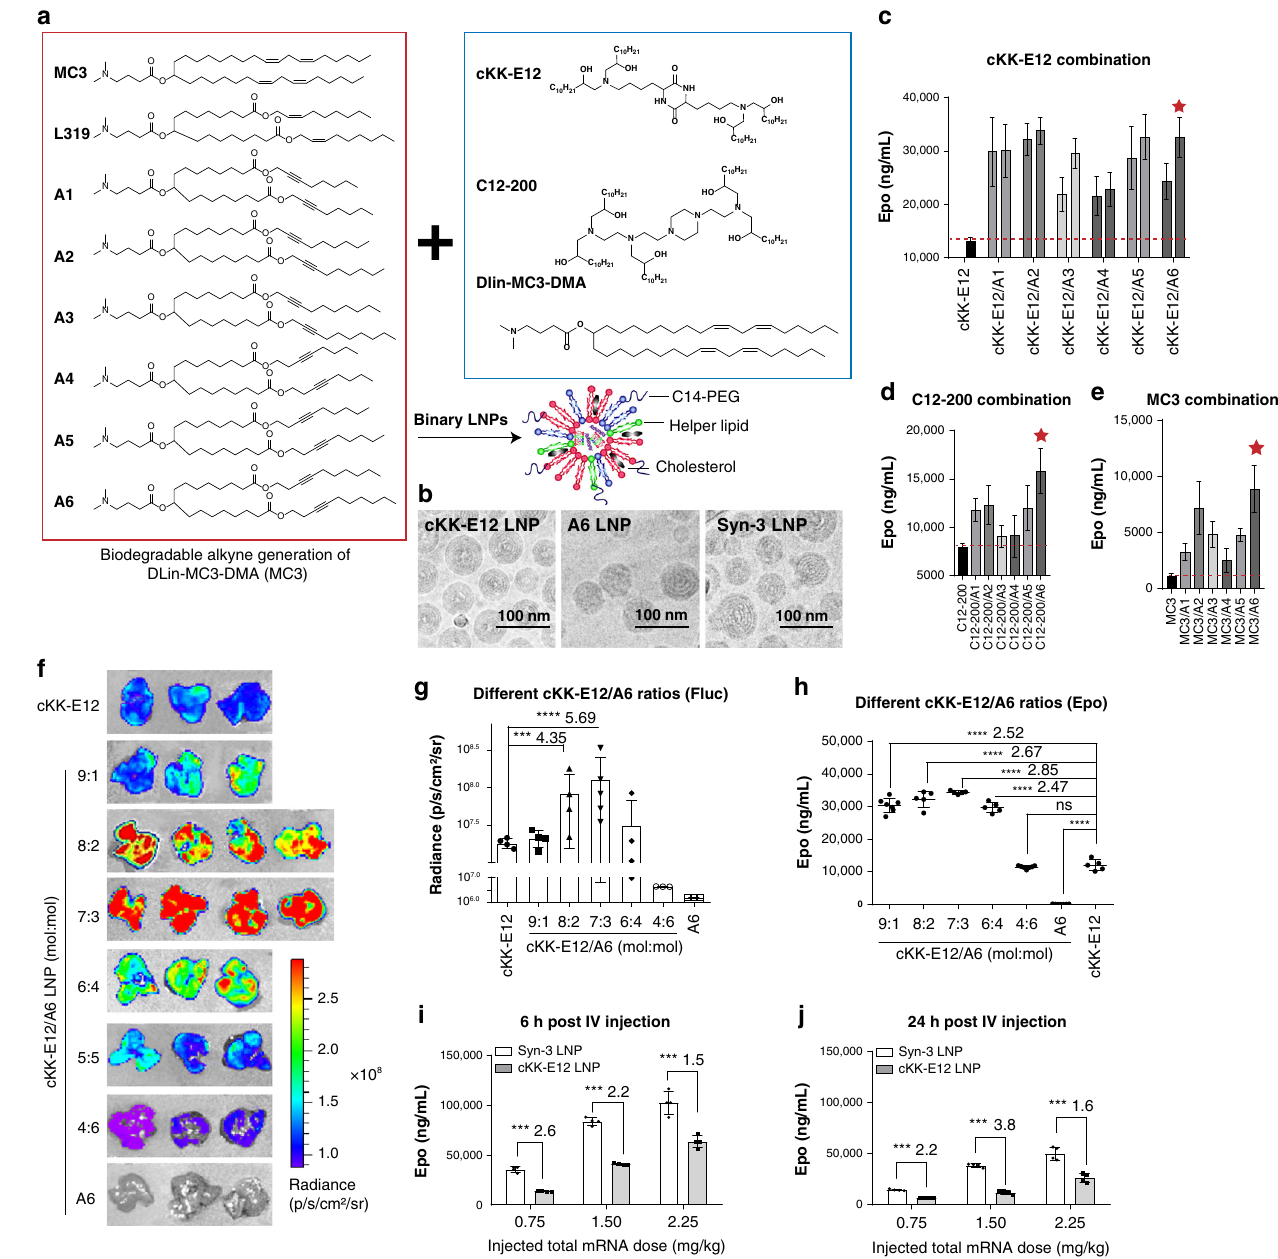
Fig. 1 LNPs containing multiple ionizable lipids demonstrate synergistic mRNA expression in vivo. a Design of biodegradable alkyne lipids and layout of the combination strategy. b Cryo-EM image and schematic illustration of mRNA loaded LNPs. c – e I.v. injection of hEPO mRNA loaded LNPs containing two different ionizable lipids (0.75 mg/kg of hEPO mRNA). c cKK-E12 and alkyne lipid combinations were evaluated at two molar ratios (left: 5:5, right: 7:3); combination of C12-200 and MC3 with alkyne lipids were evaluated at molar ratio 7:3, respectively. Formulation includes a composition of ionizable lipid: DOPE:cholesterol:C14-PEG2000 at the molar ratio of 35:16.0:46.5:2.5. Six hours after injection, hEPO protein in the serum was detected and quanti fi ed using hEPO ELISA. Red stars highlight the top-performing synergistic LNPs ( n = 4/group). f , g IVIS images and quanti fi cation of luciferase expression. mRNA encoding fi re fl y luciferase mRNA (Fluc mRNA) was formulated with LNPs composed of various molar ratios of cKK-E12 and A6. A molar ratio of cKK-E12:A6 at 7:3 (Syn-3) demonstrated the most robust enhancement in Fluc protein expression in the liver ( n = 4 in cKK-E12, 9:1, 8:2, 6:4, n = 5 in 7:3 group, n = 3 in 4:6 and A6 groups, representative images were shown in f ). h The optimal ratio of cKK-E12:A6 in the LNP formulation was also evaluated using hEPO mRNA. The optimal ratio was also found to be 7:3. i , j Dose-dependent and time-dependent protein expression using Syn-3 (cKK-E12:A6 is 7:3) LNPs was compared with cKK-E12 LNPs, and demonstrated superior gene expression in vivo. Data are presented as mean ± SD. *** P < 0.001, **** P < 0.0001, Student ’ s T-test comparing to cKK-E12